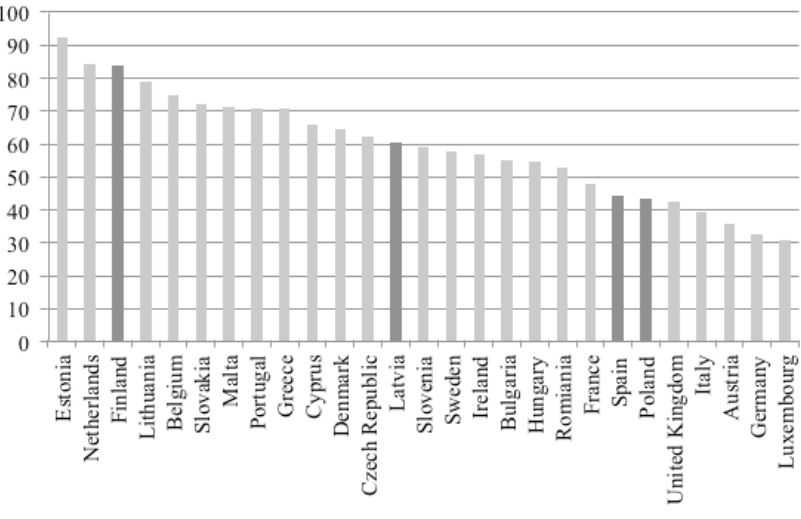
Fig. 1. European banking markets’ concentration ratio (CR5) in 2010 (ECB 2012, 1) Finland represents a highly concentrated market. Latvia is one of the countries in the middle of the scale. Spain is one of the banking markets with a low level of concentration ratio. Poland was chosen because today its banking market is one of the most interesting markets in Europe. Despite the global financial crisis, it generates increasing incomes. In 2011 the net profit of banks in Poland was 15, 7 billion PLN with revenues over 90,9 billion PLN, which is the best result in history. Furthermore, the rate of equity (ROE) was 12% and capital adequacy ratio – 13%. The figures